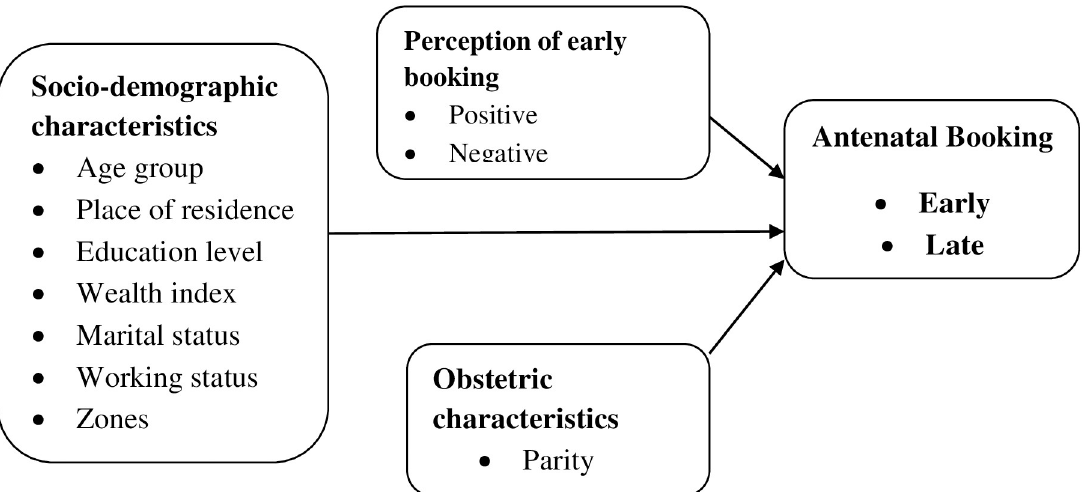
Fig 1. Conceptual framework on factors influencing early antenatal